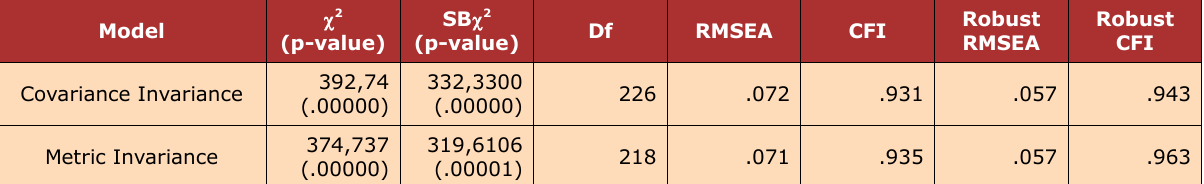
Table 8. Goodness of fit indexes for covariance invariance